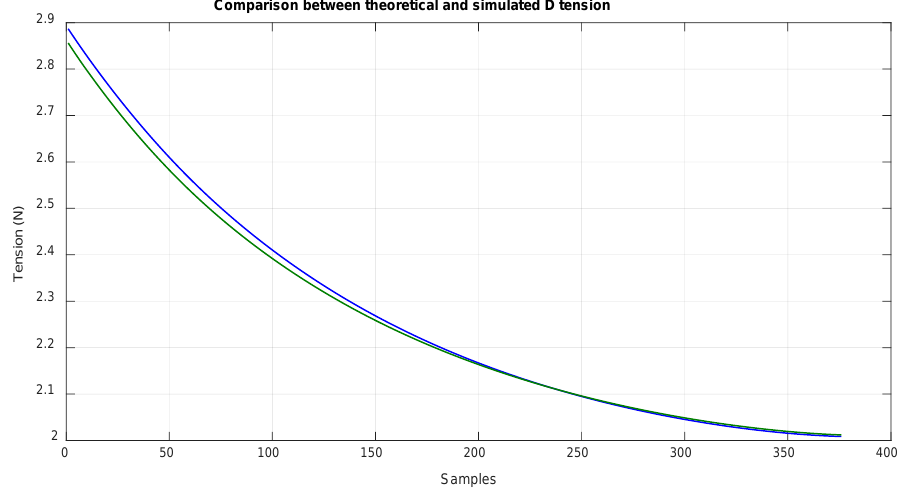
Figure 15. Comparison of the theoretical tension of D cable (blue) and the simulated tension of D cable (green).